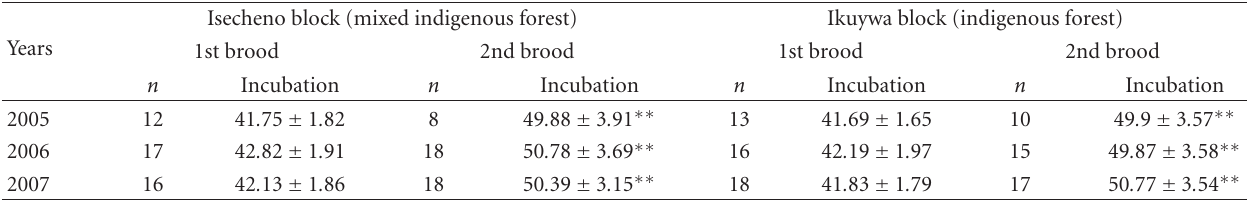
Table 1: Means ( ± SD) incubation period in days of Anaphe panda in the Indigenous and mixed indigenous forest in Kakamega. Isecheno block (mixed indigenous forest) Years